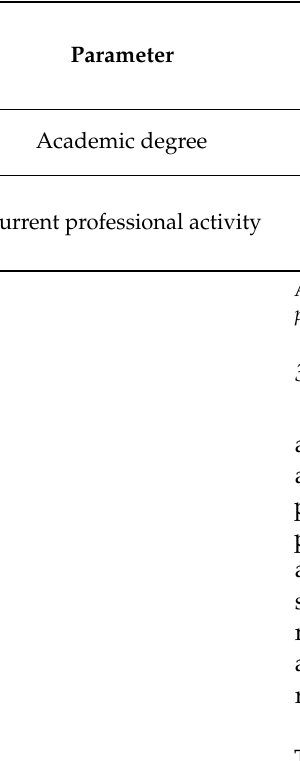
Table 5. Factors associated with perceived ease of use and behavioural intention to use